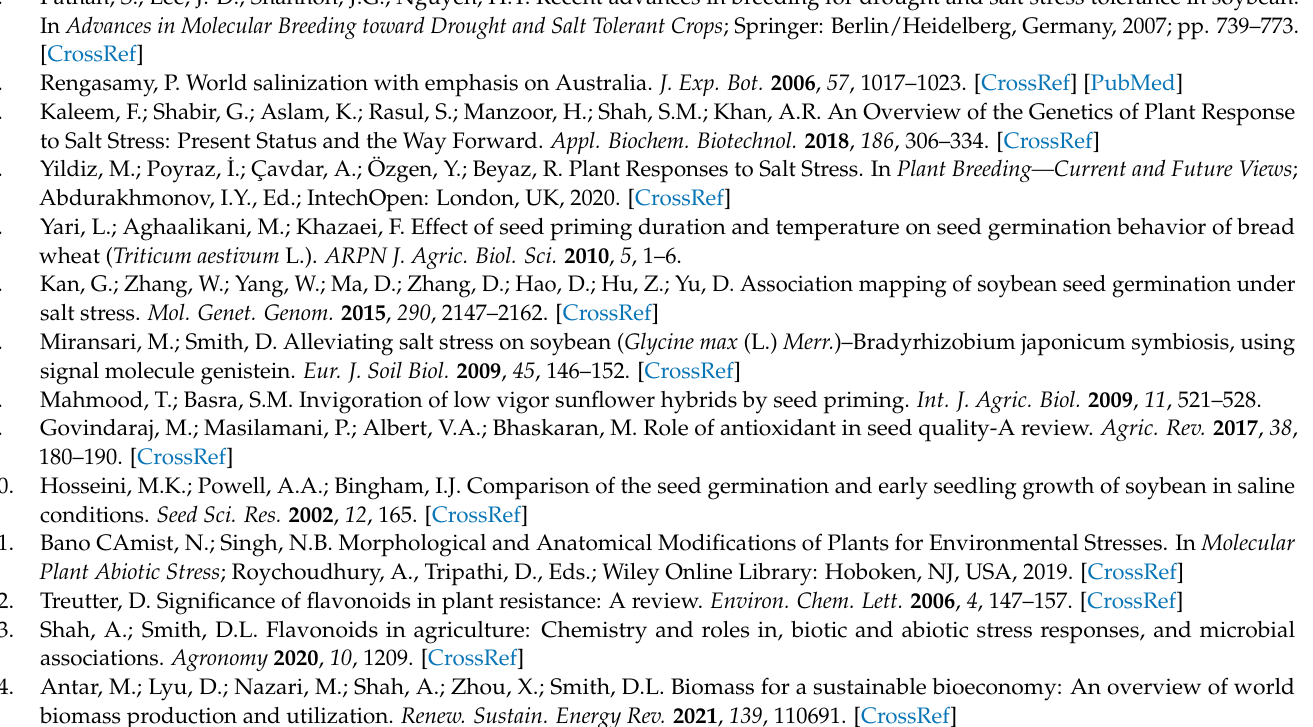
Table S6: Soybean seed germination flavonoids (optimal conditions). Table S7: Soybean seed ger- mination flavonoids (80 mM NaCl conditions). Table S8: Soybean seed germination flavonoids (100 mM NaCl conditions). Table S9: Soybean seed germination flavonoids (120 mM NaCl con- ditions). Table S10: Canola seed germination CFS (optimal conditions). Table S11: Canola seed germination CFS (150 mM NaCl conditions). Table S12: Soybean seed germination CFS (optimal conditions). Table S13: Soybean seed germination CFS (100 mM NaCl conditions). Table S14: Canola seed germination CFS and flavonoids (combined) (optimal conditions). Table S15: Canola seed germination CFS and flavonoids (combined) (150 mM NaCl conditions). Table S16: Soybean seed ger- mination flavonoids and CFS (Combined) (optimal conditions). Table S17: Soybean seed germination flavonoids and CFS (Combined) (100 mM NaCl